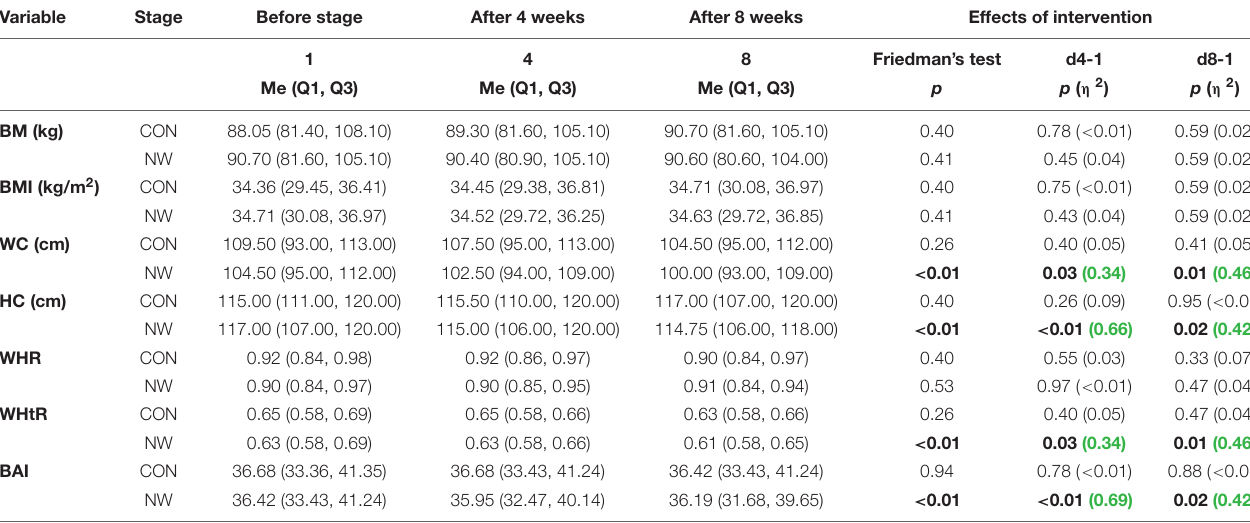
TABLE 5 | Somatic characteristics of participants during the control (CON) and Nordic walking (NW) stages.